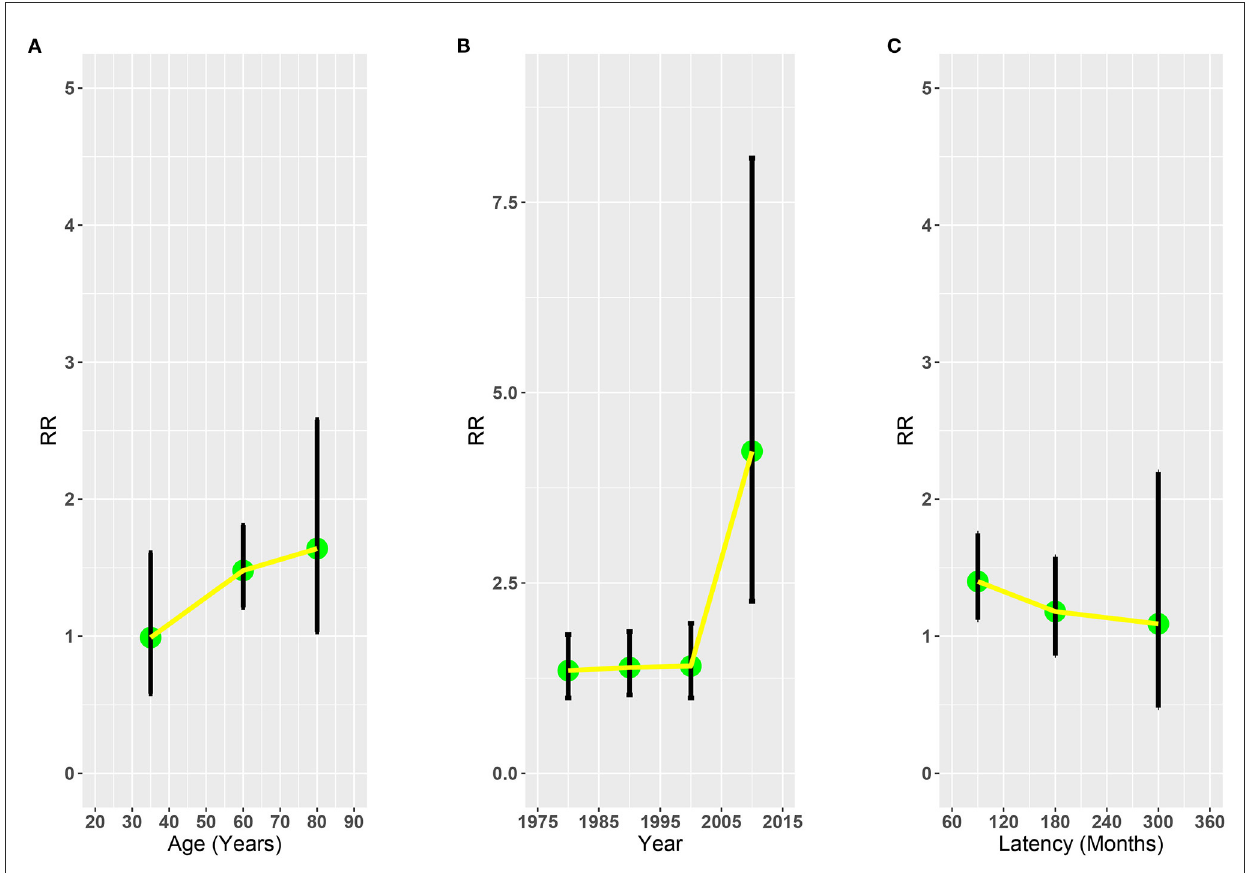
FIGURE3 Adjusted relative risk plots of SLC of patients with OCC treated with RT or without RT. (A) Age at OCC diagnosis. (B) Year of OCC diagnosis. (C) Latency time. RR, relative risk; OCC, oral cavity cancer; RT, radiotherapy; SLC, second primary lung